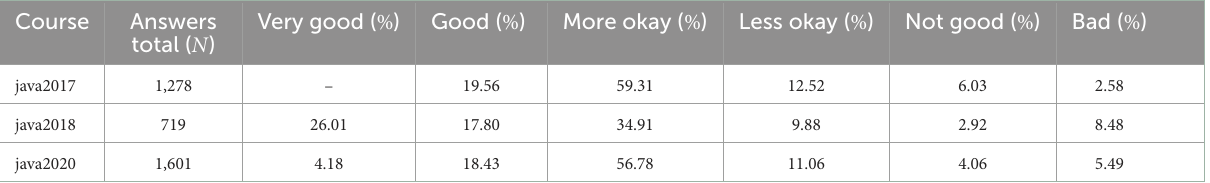
TABLE 6 Learner perception of story elements in all three evaluated Java courses; option “very good” was not available in java2017 (Hagedorn et al., 2022).